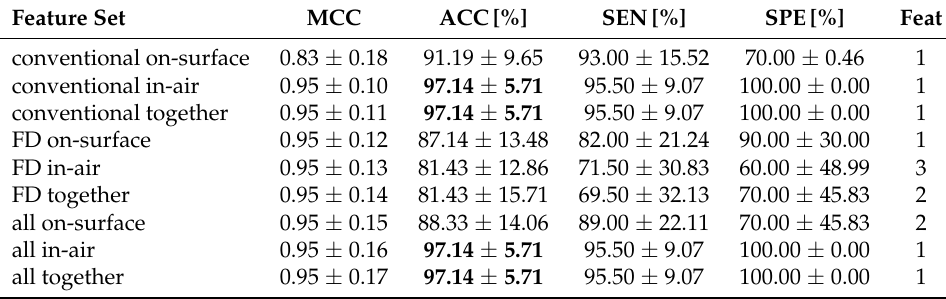
Table 6. Results of multivariate binary classification analysis